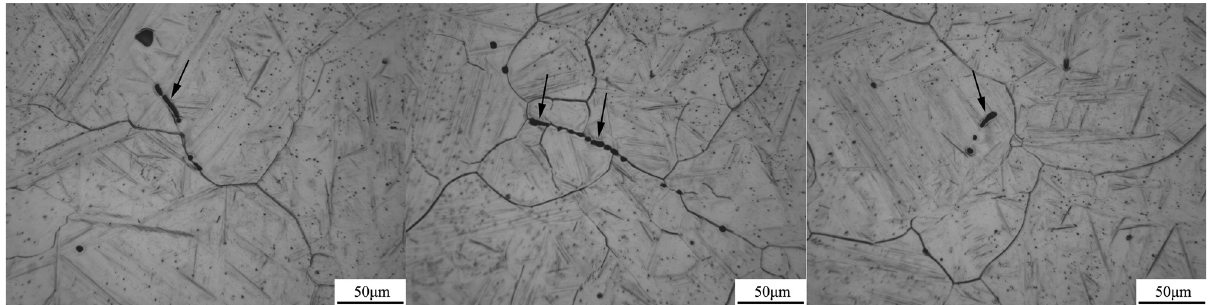
Figure 9: The morphology of MnS in sample cooled after in situ